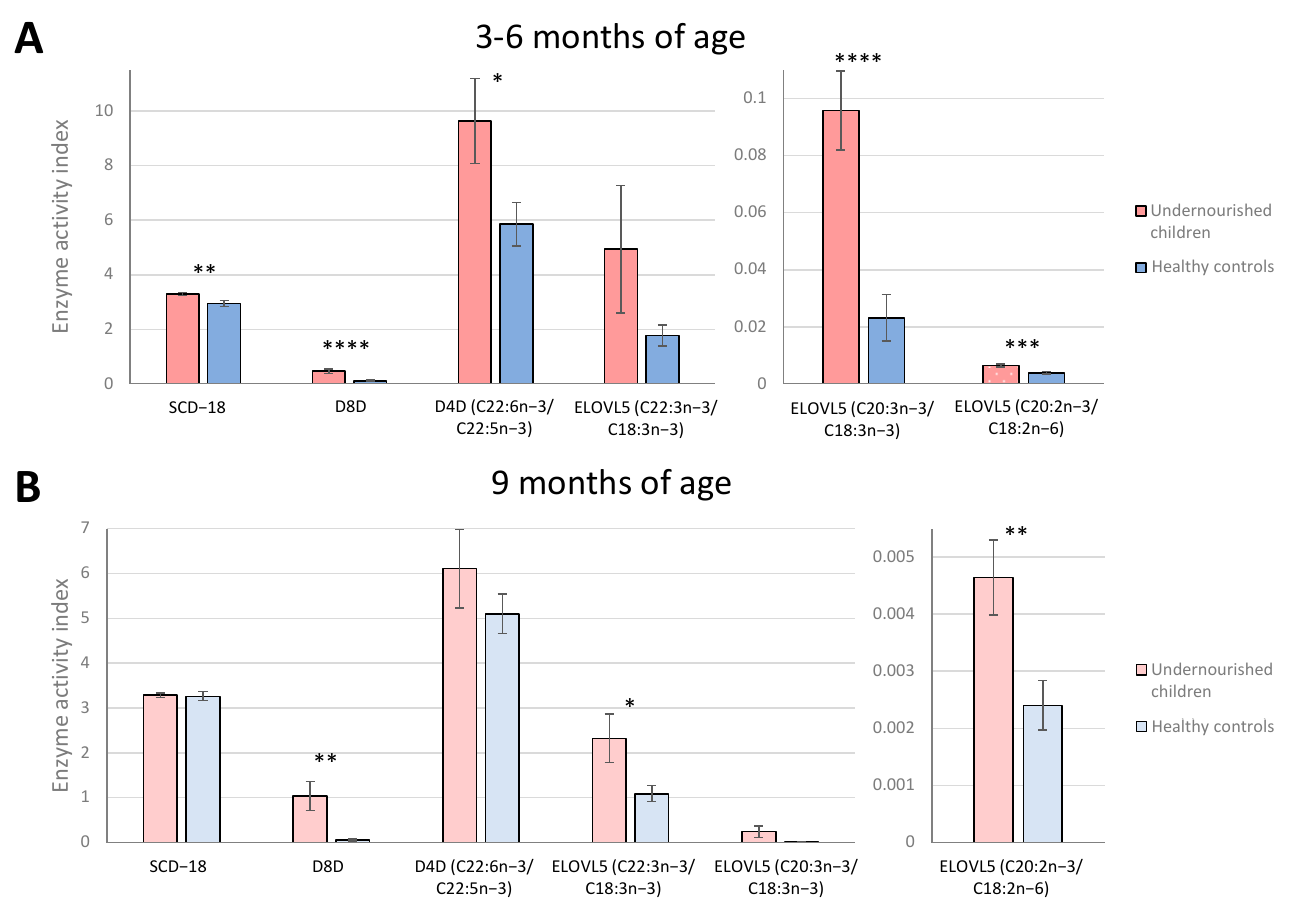
SCD: stearoyl-CoA desaturase, D4D: delta-4-desaturase, D5D: delta-5-desaturase, D6D: delta-6-de- saturase, D8D: delta-8-desaturase, ELOVL5: elongase 5, ELOVL6: elongase 6, ND: non detected. More information in Supplementary Figure S2.